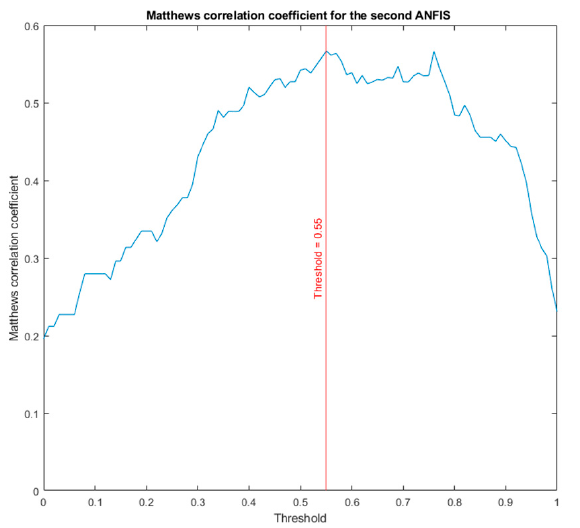
Figure 4. Determination of the optimal threshold for the second ANFIS for AHI = 10.